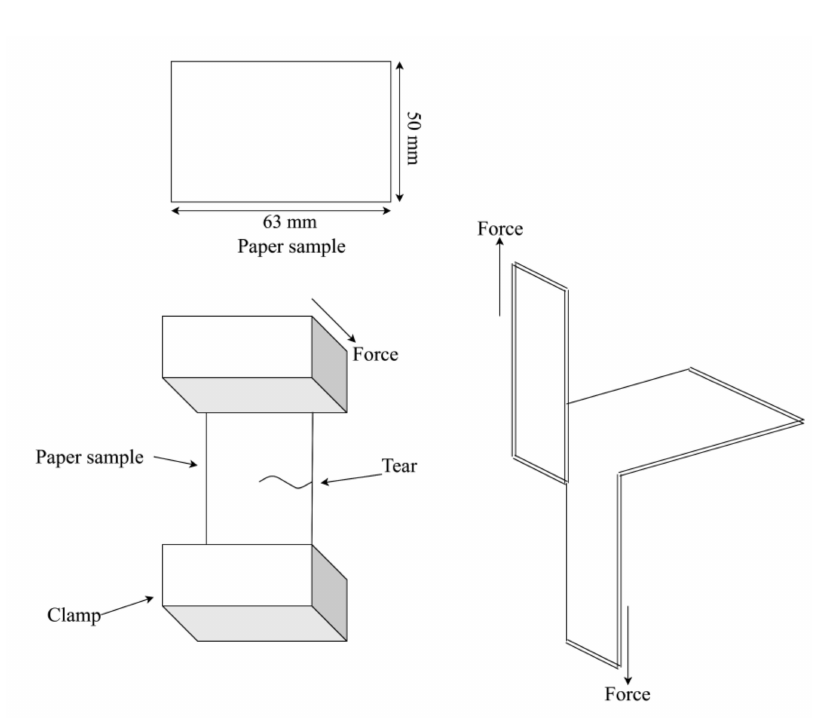
Figure 13. Tear strength measurement procedure.